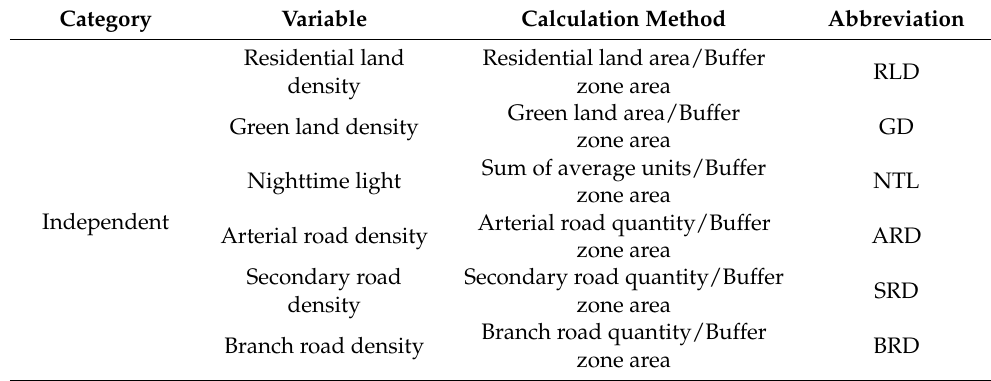
Table 1. Footpath environmental indicator